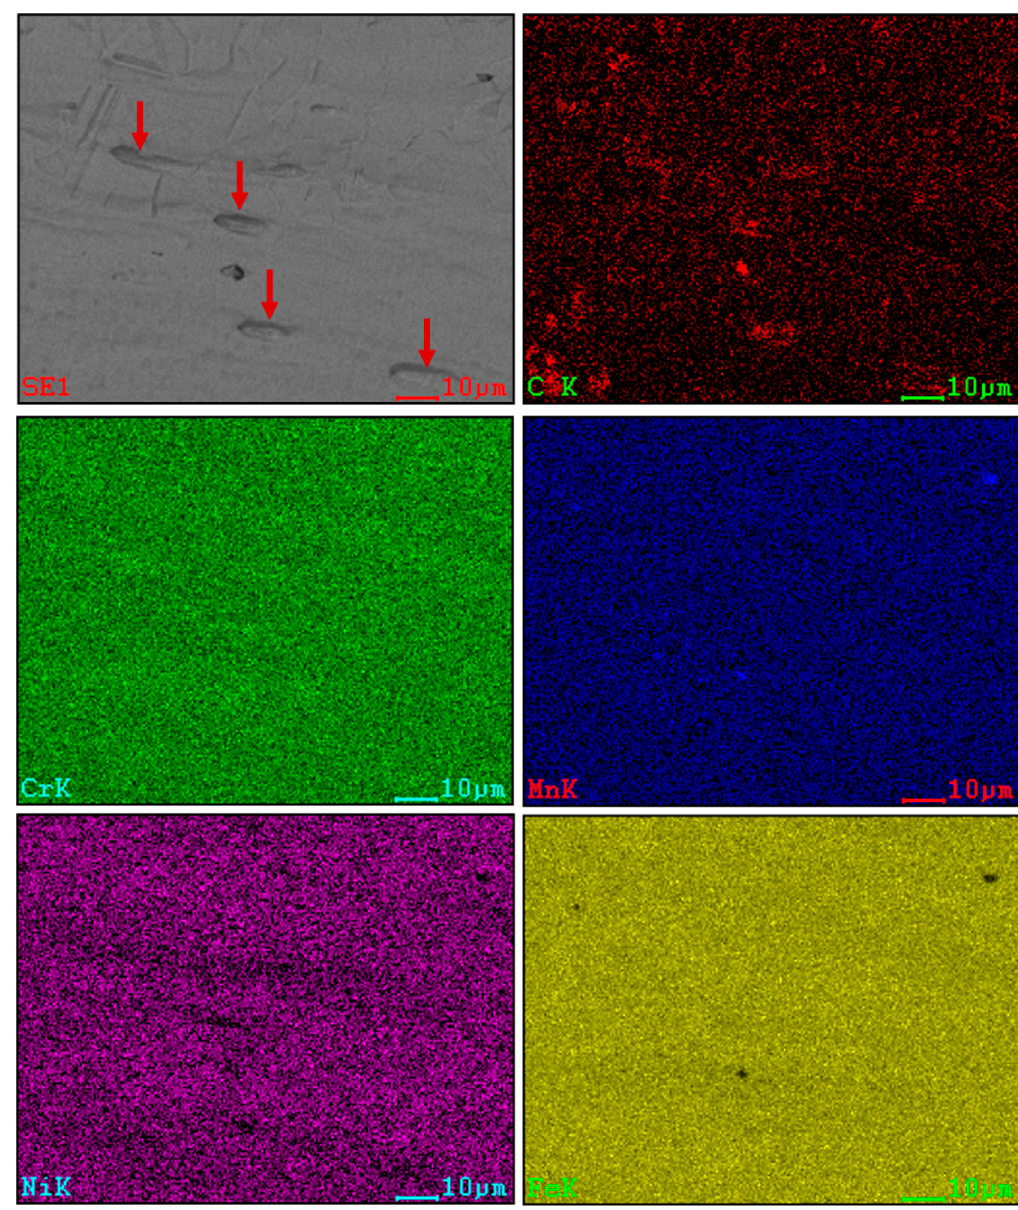
Figure 4. SEM photo of etched 301ASS-0.4Cu and surface scan photos of the main alloying